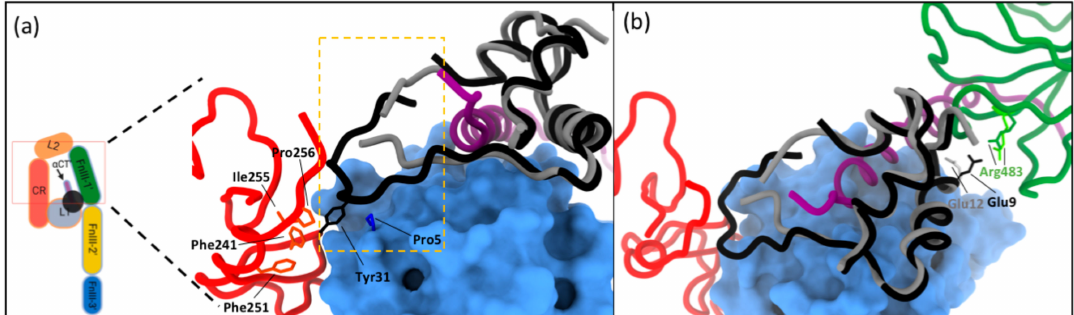
Figure 5. ( a ) Interaction of the C-domain (shown in yellow box) of IGF-II (grey) and IGF-I (black) with IGF-1R (PDB: 6VWI and 6PYH, respectively). Domains of IGF-1R coloured as in Figure 3. Residues of the CR and L1 domain engage with residue Tyr31 of IGF-I. Contact is also made between C-domain residues Arg36 and Arg37 of IGF-I and the L2 domain. There is no equivalent C-domain residue in IGF-II. ( b ) Site 2 contacts involve residues Glu12 of IGF-II and Glu9 IGF-I which contact FnIII-1 domain residue Arg483 (dark green represents the IGF-1:IGF-1R structure and light green the IGF-II:IGF-1R structure). ( a , b ) coloured as in Figure